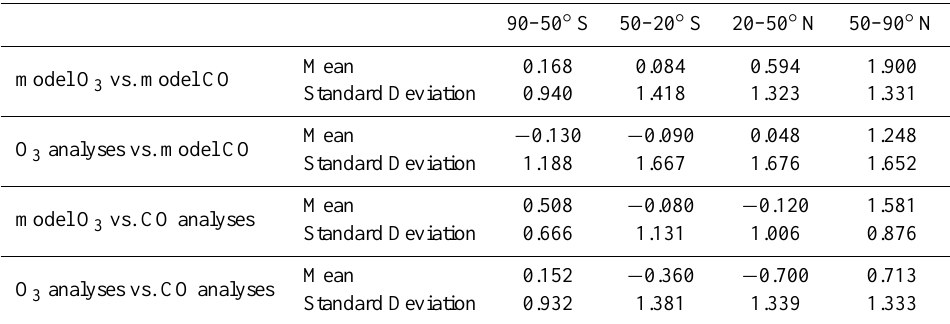
Table 4. Heights of the mean and standard deviation of the ExTL distribution in relative altitude space (km) for the different experiments and for the different latitude bands over the globe, calculated from monthly average (August 2007) tracer fields. Negative and positive mean values are below and above the thermal tropopause,